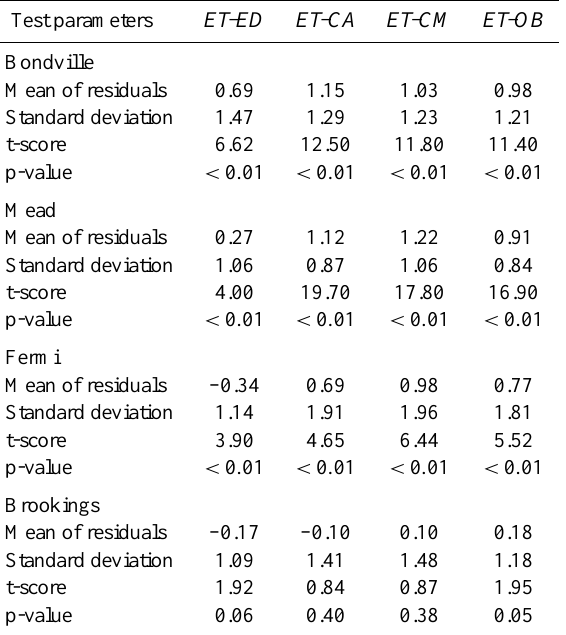
Table 2b. Presence of bias in VegET outcomes from different phe- nological parameterization sources: distributions are structured by